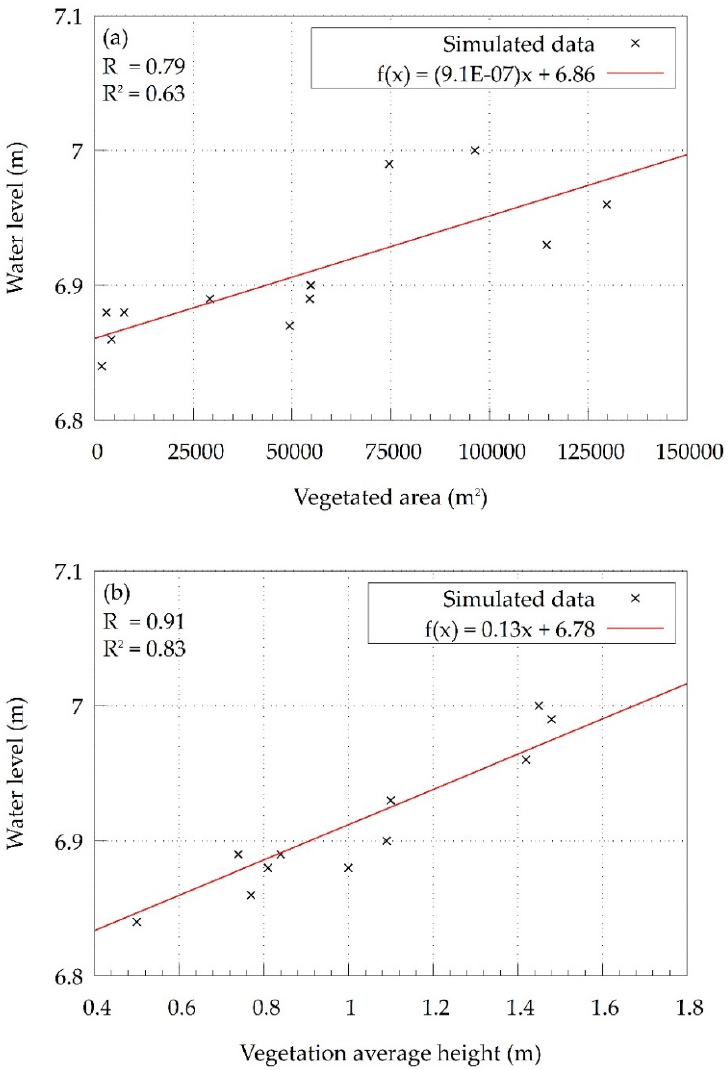
Figure 14. Linear relationship between the water level in the middle section of the UAV observed area and the vegetation parameters: ( a ) area; ( b ) average area and the vegetation parameters: ( a ) area; ( b ) average height.